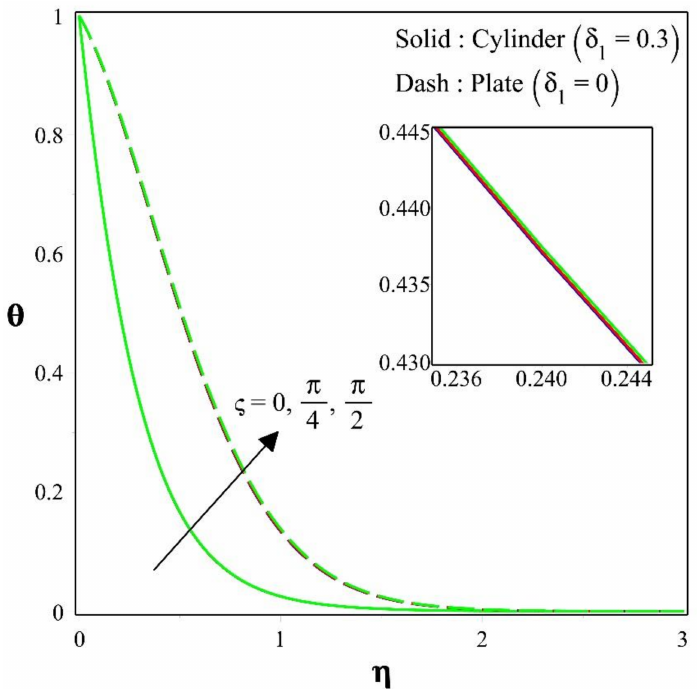
Figure 7. The role of inclined angle on temperature profile (keeping P m = γ 1 = 0.1, φ 1 = φ 2 = φ 3 = 0.01 & H = SS